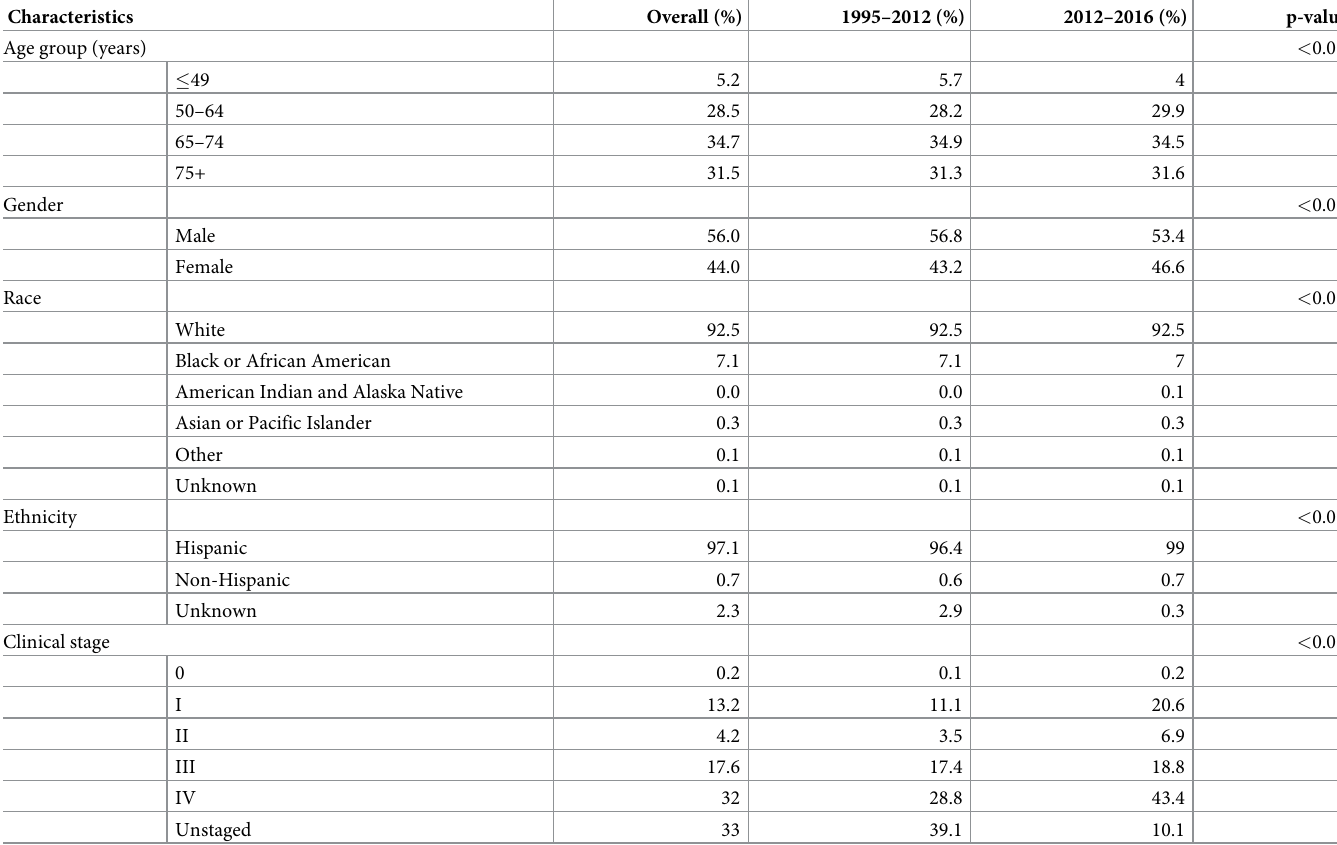
Table 1. Patient demographics of Indiana residents diagnosed with lung cancer (n = 110,935).